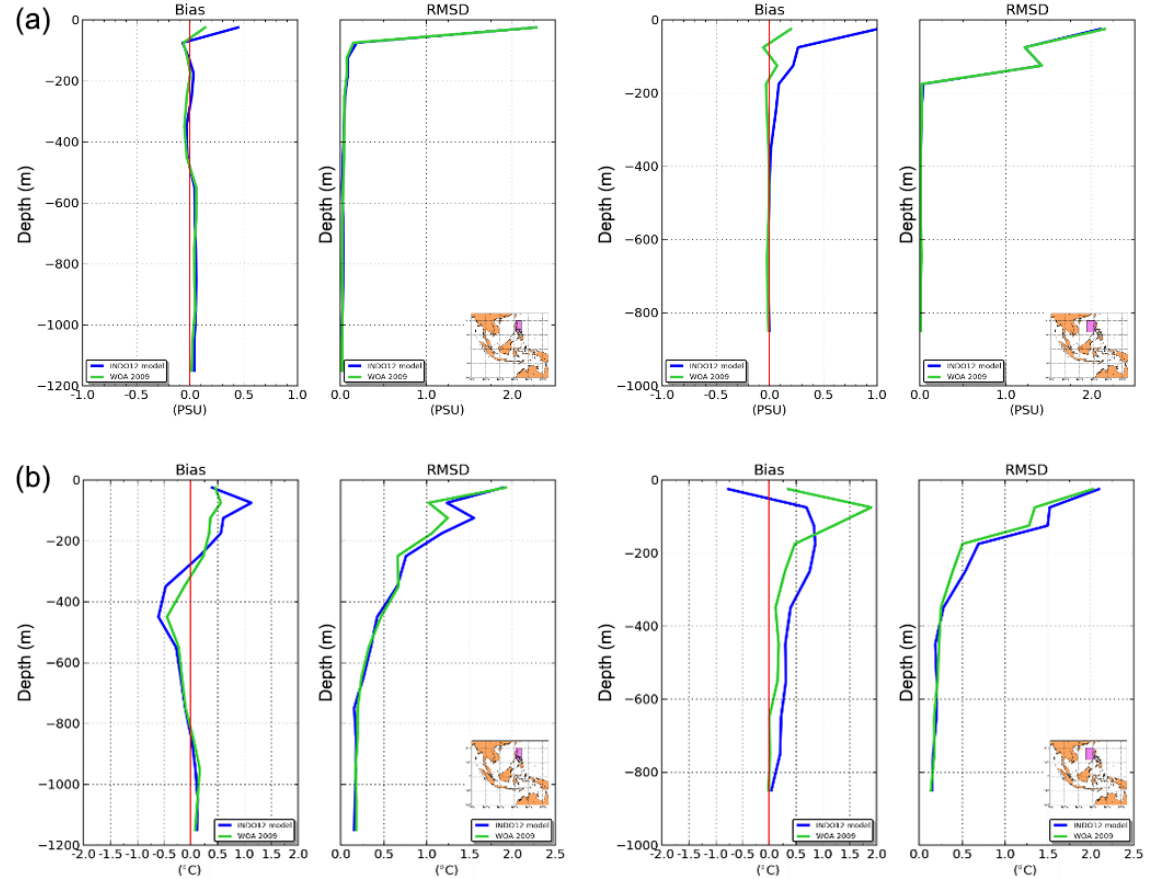
Figure 23. Bias and RMSD of salinity between real data (WOD 2013) and INDO12 (blue) and WOA 2009 (green) on both sides of Luzon Strait (purple squares) from October to December 2013. Data are binned in 50m depth intervals for the first 200m depths and in 100m depth interval for deeper